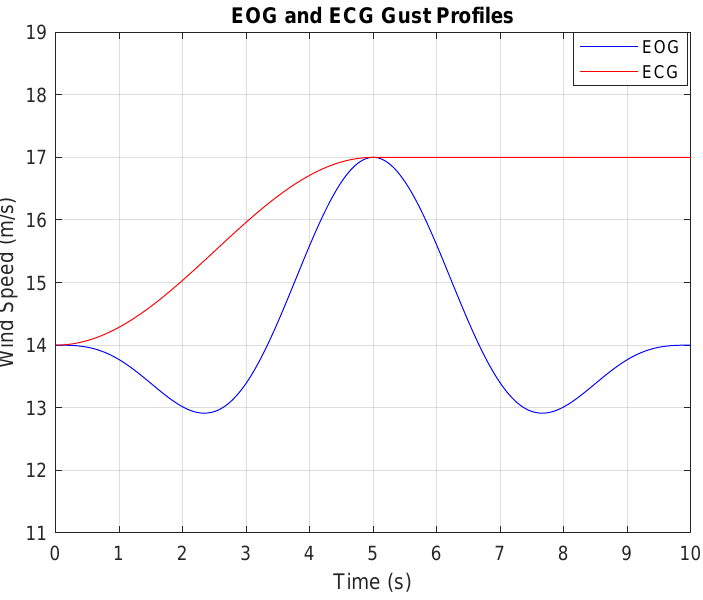
Figure 3. EOG and ECG profiles with rise times of 5